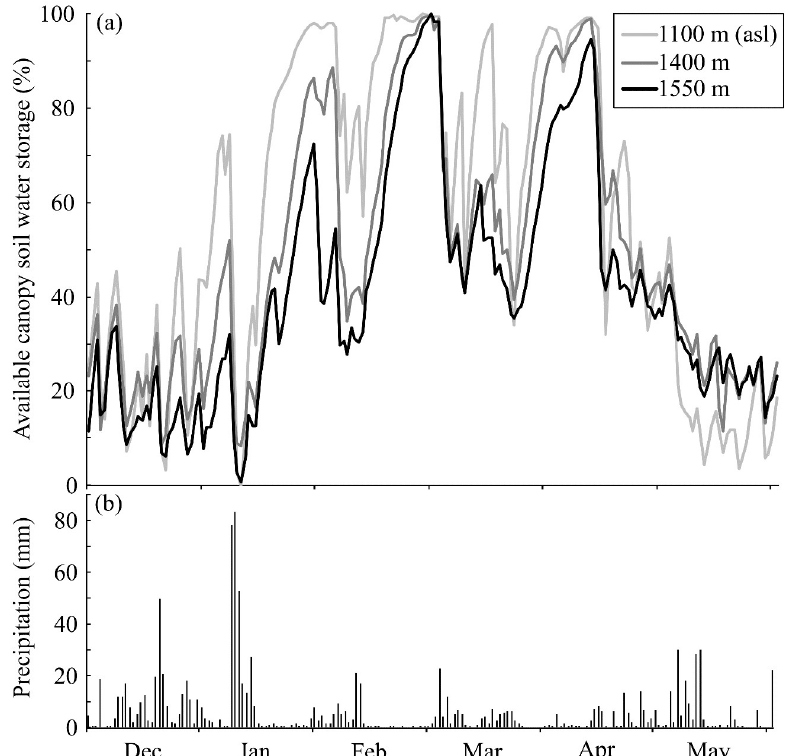
Figure 6. ( a ) Available canopy soil water storage of canopy organic matter, December 2016 to May 2017 at three sites in a tropical montane region in Costa Rica. Volumetric soil moisture content was measured with a soil moisture probe (METER Group, EC-5). Since the soil moisture probes are still deployed, calibration of soils was not possible. Since some probes logged negative values in the dry period in this study due to this lack of calibration, data were scaled across sites by assuming that the lowest value in the driest part of the dry season was 0 (mm 3 /mm 3 ) in all sites. The max. value was set as 100% saturation, then the inverse of that was plotted to show the available canopy soil water storage. ( b ) Precipitation at the uppermost site is plotted (while total precipitation is lower at lower elevations, the patterns of rainfall are similar in all sites).